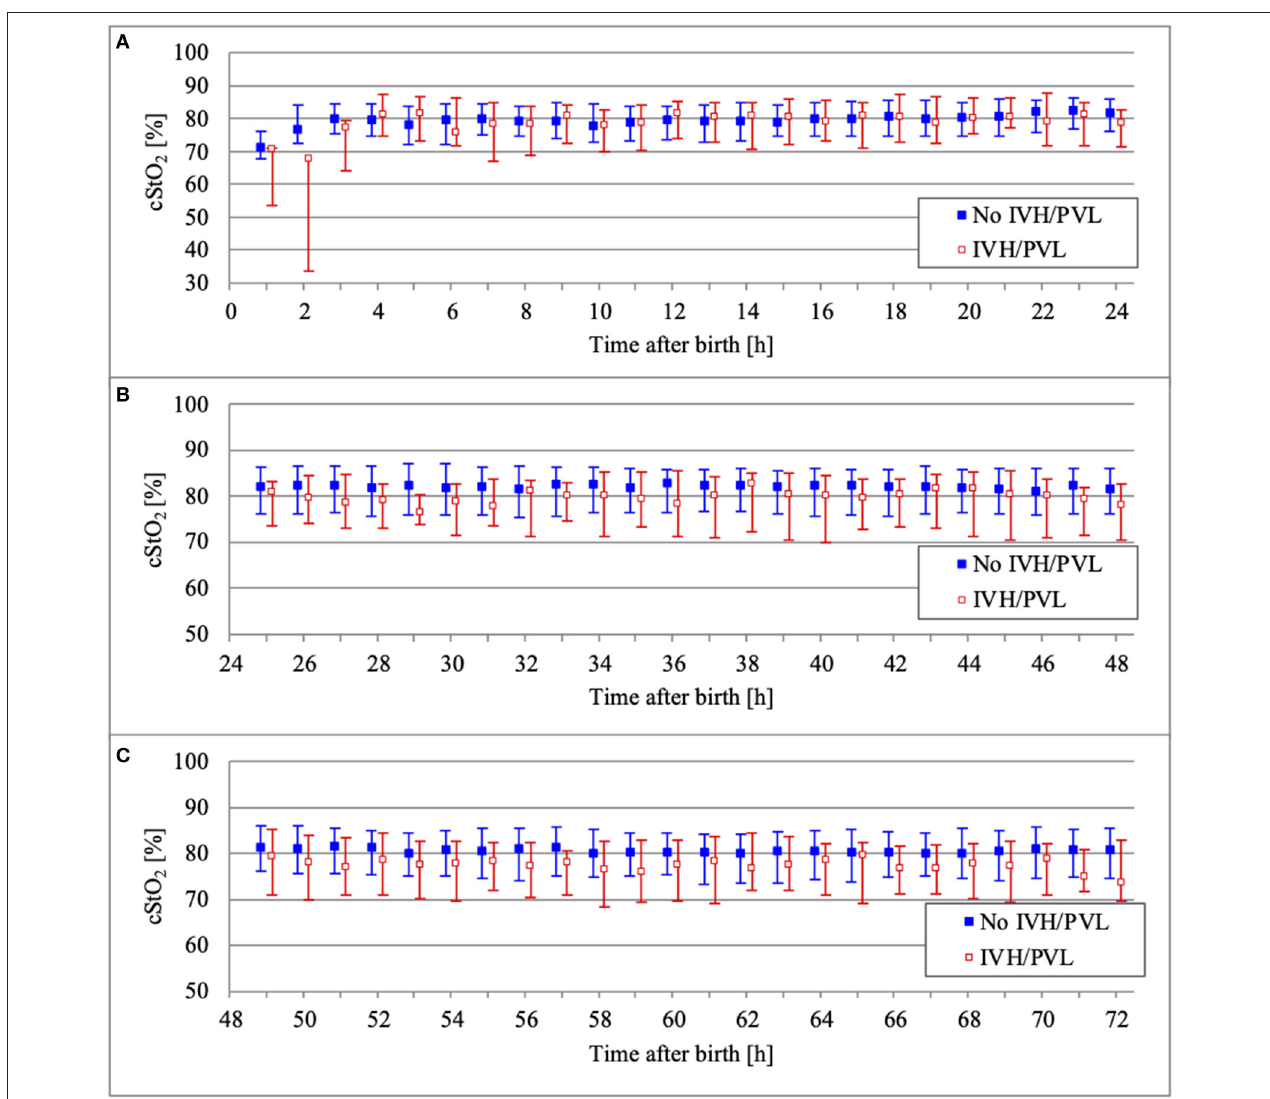
FIGURE 3 | Comparison of cStO 2 (median and interquartile range over 1h) between outcome groups on the first day of life (A) , on the second day of life (B) , and on the third day of life (C) .